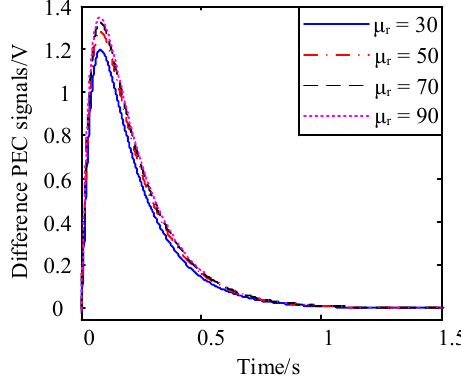
Figure 5. The difference in PEC signals.